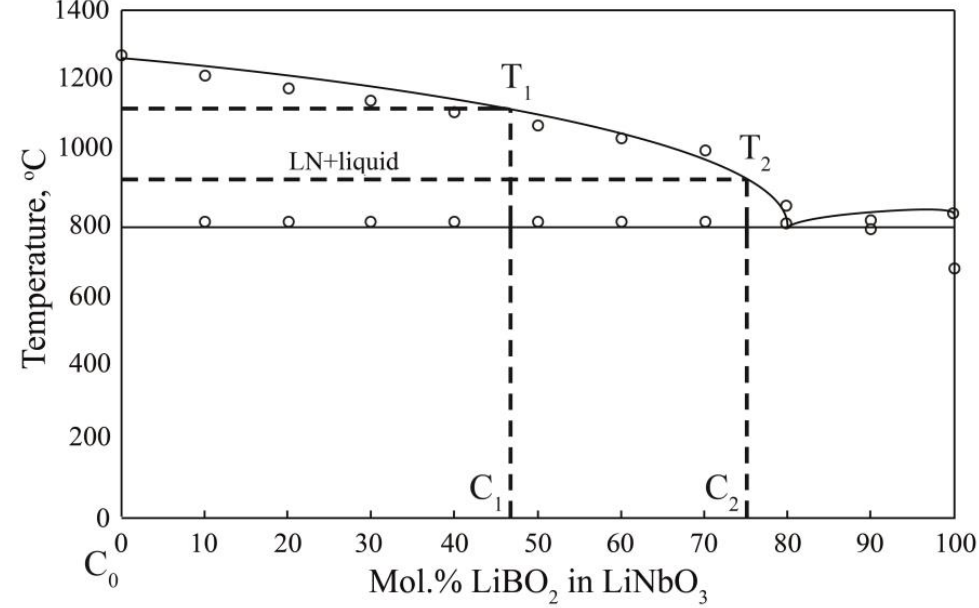
Figure 5. Polythermal incision LiNbO 3 -LiBO 2 of a quasi-ternary Li 2 O-Nb 2 O 5 -B 2 O 3 system state diagram. C 0 , C 1 and C 2 are the melt composition or boron concentration in the melt; T 1 and T 2 are the crystallization temperatures corresponding to melt compositions C 1 and C 2 . The figure is reproduced from the paper Crystals 2021 11(5) 458 10.3390/cryst11050458 (ref. [9]).